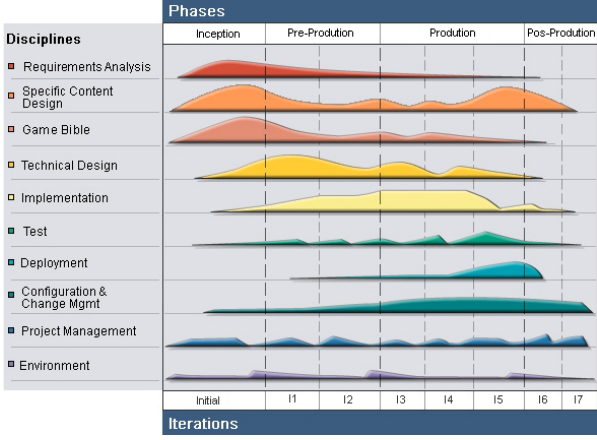
Fig. 2. Structure of the Serious Game Unified Process (SGUP).